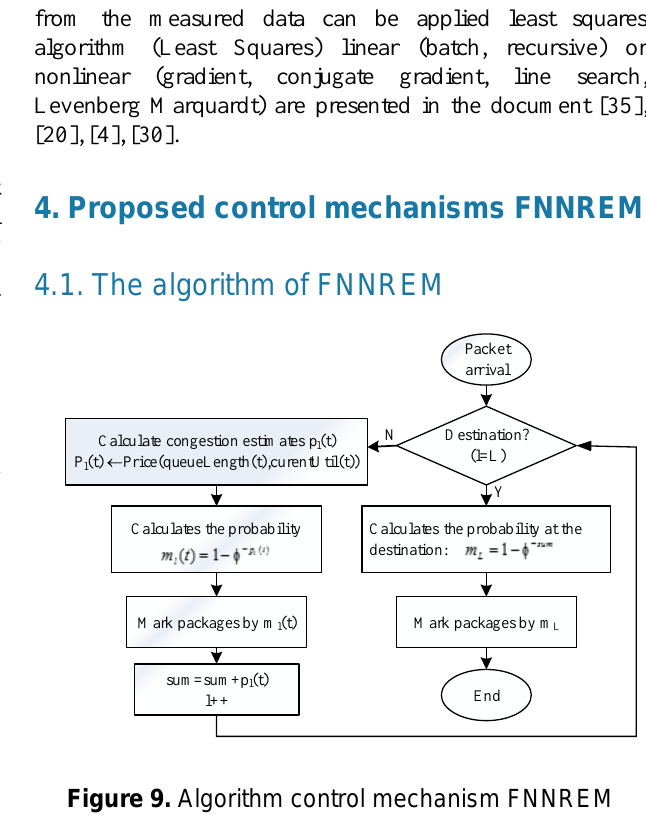
Figure 9. Algorithm control mechanism FNNREM